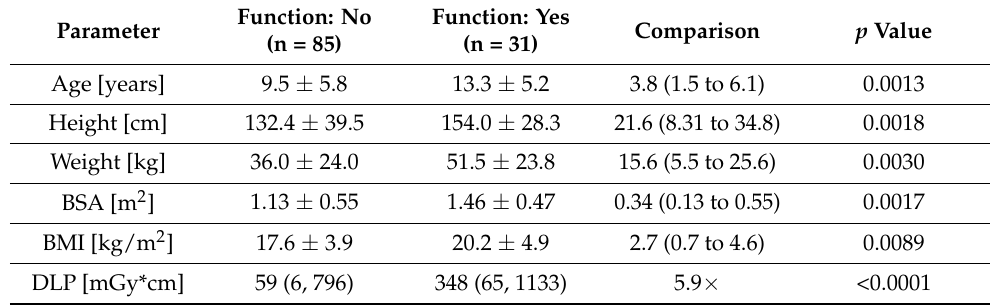
Table 4. Influence of cardiac function assessment on radiation dose of cardiac CT scan in children. All